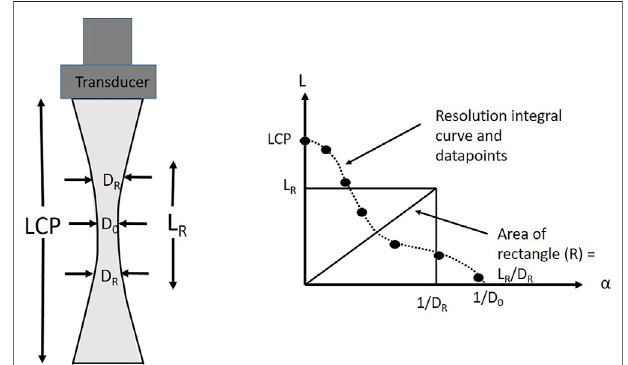
FIGURE 1 | The graph shows a schematic resolution integral curve with data-points,includinglowcontrastpenetration(LCP),characteristicresolution (D R ) and depth of fi eld, (L R ). The schematic fi gure on the LHS shows a weakly focused beam with minimum beamwidth D 0 . Note that the area under the resolution integral curve is equal to R, and the area under the constructed rectangle is also R (=L R /D R